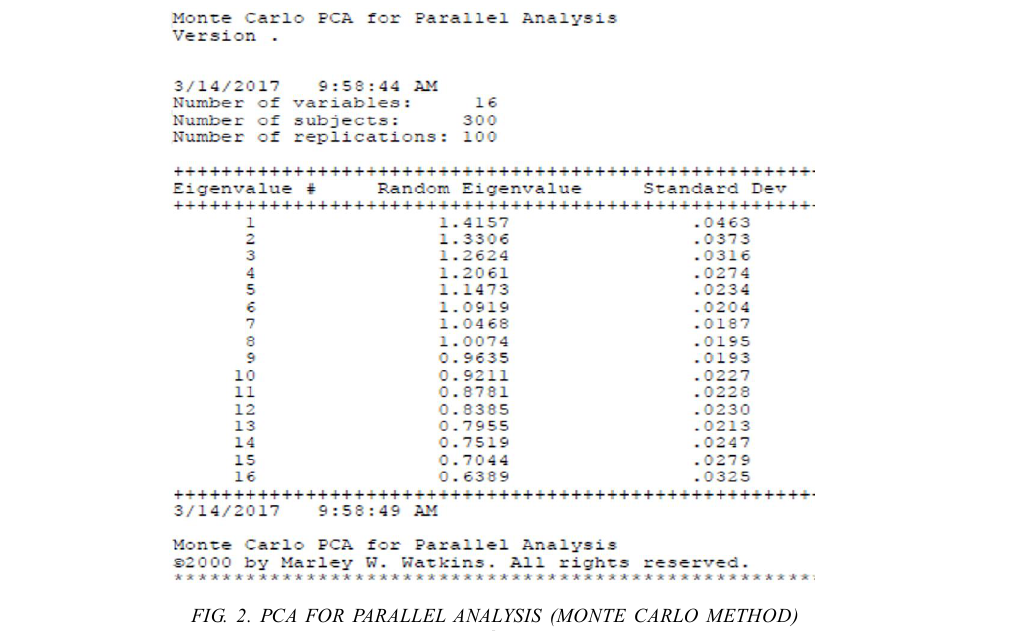
FIG. 2. PCA FOR PARALLEL ANALYSIS (MONTE CARLO